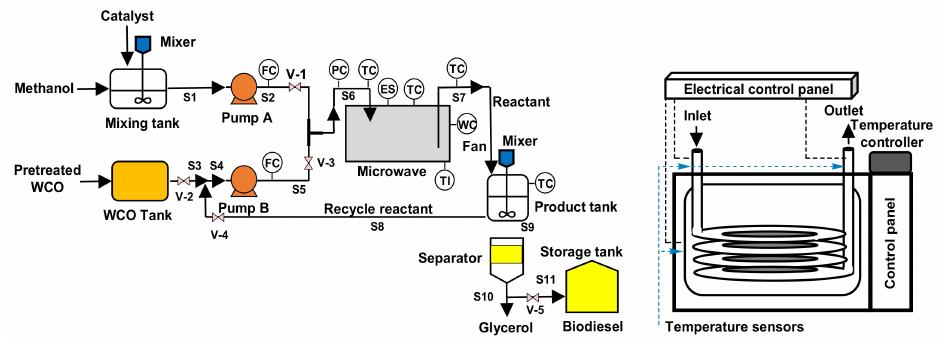
Figure 17. Continuous microwave assisted reactor for the biodiesel production. Steam number